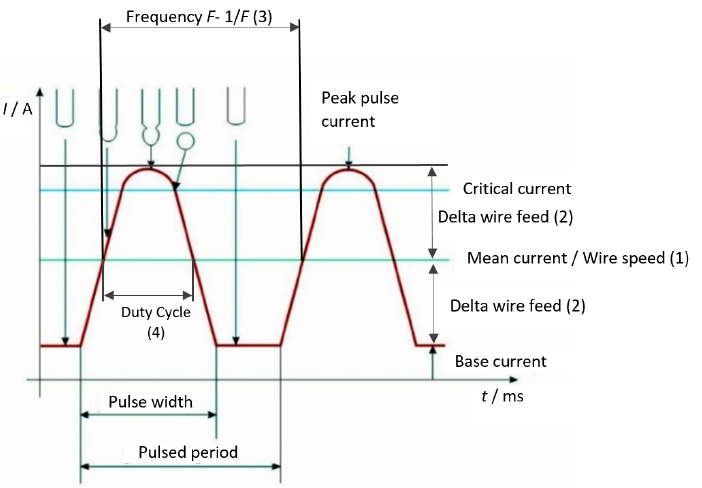
Figure 1. Graphic representation of metal transfer in the pulse current [11].